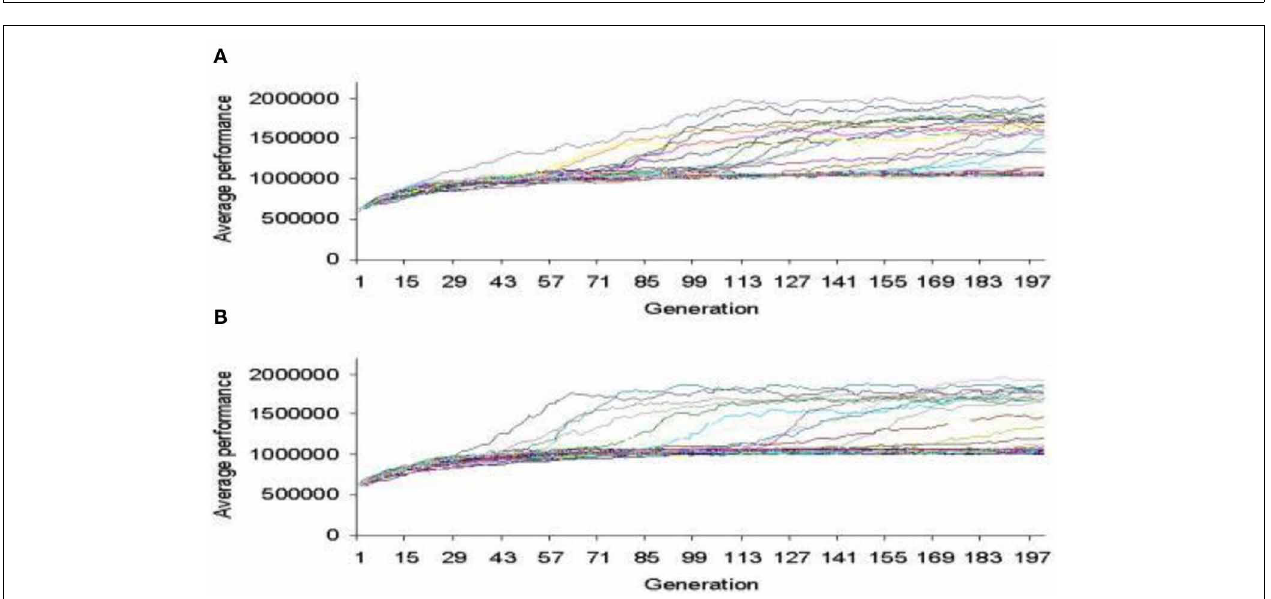
FIGURE 7 | Bacterial chromosome (left) with 14 genes codifying for the main characteristics of an AM radio receiver (right) (Perales-Graván and Lahoz-Beltra, 2008).